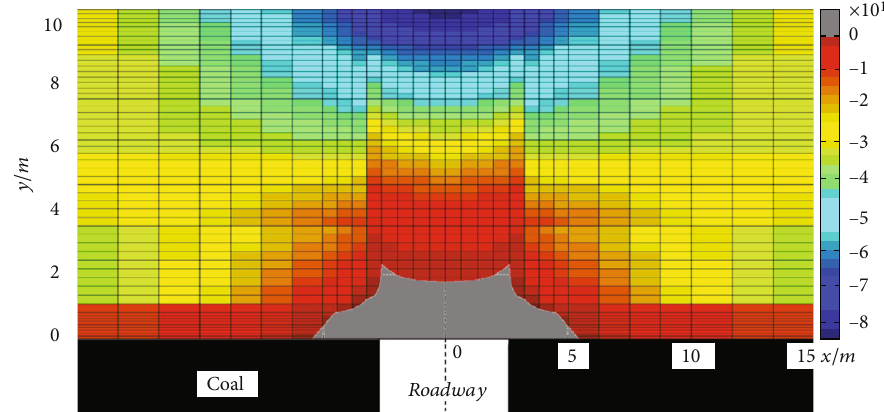
Figure 5: Failure factor cloud chart of the composite